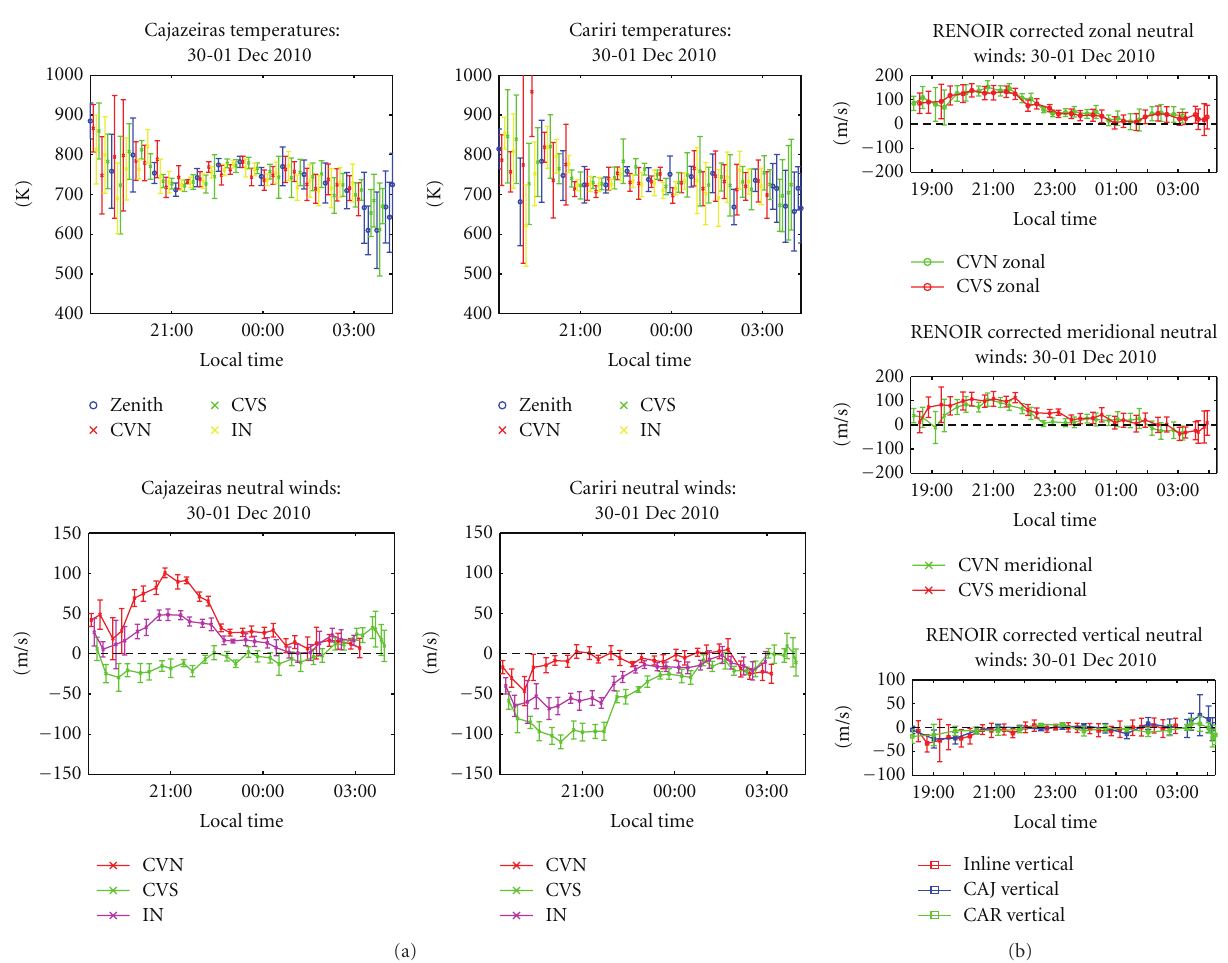
Figure 4: Example of temperatures and common-volume vector neutral winds derived from data obtained from two FPI observatories located in northeastern Brazil. The left two columns show the single-site (top) temperature measurements and (bottom) line-of-sight wind observations. The right column shows the derived (top) zonal and (middle) meridional winds at the (green) north and (red) south CV locations. The bottom plot shows the derived vertical wind measurements from the (red) in-line measurements as well as local zenith measurements from (blue) Cajazeiras and (green)